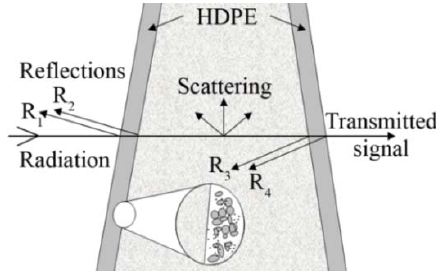
Figure 3. Wedge sample holder. The reflection coefficient of the surface to wall material interface is approximately constant by